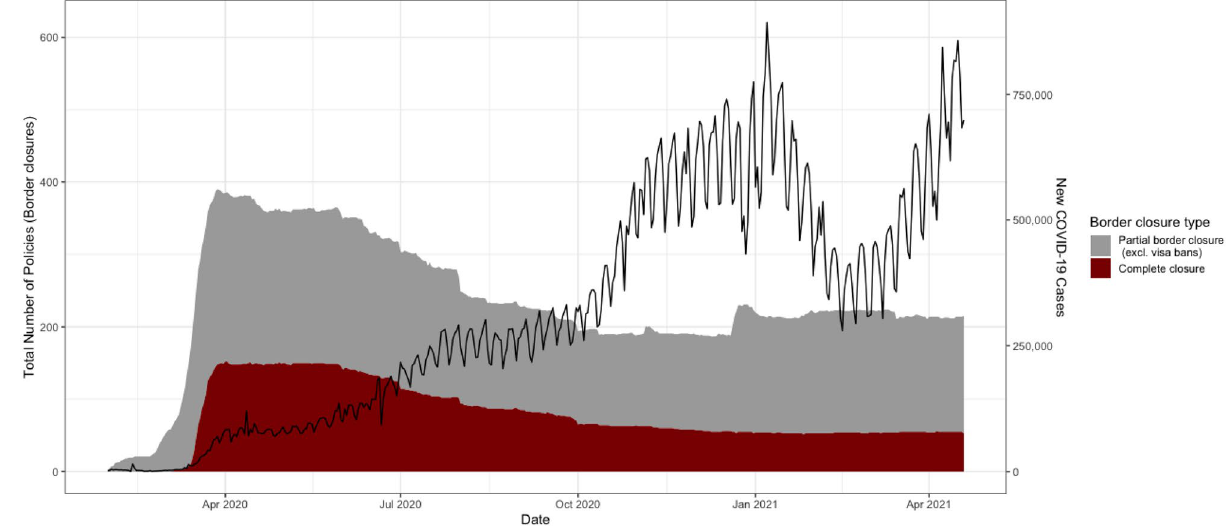
Figure 1. Descriptive data of border closure policies and new Covid-19 cases from January, 2020 until April,